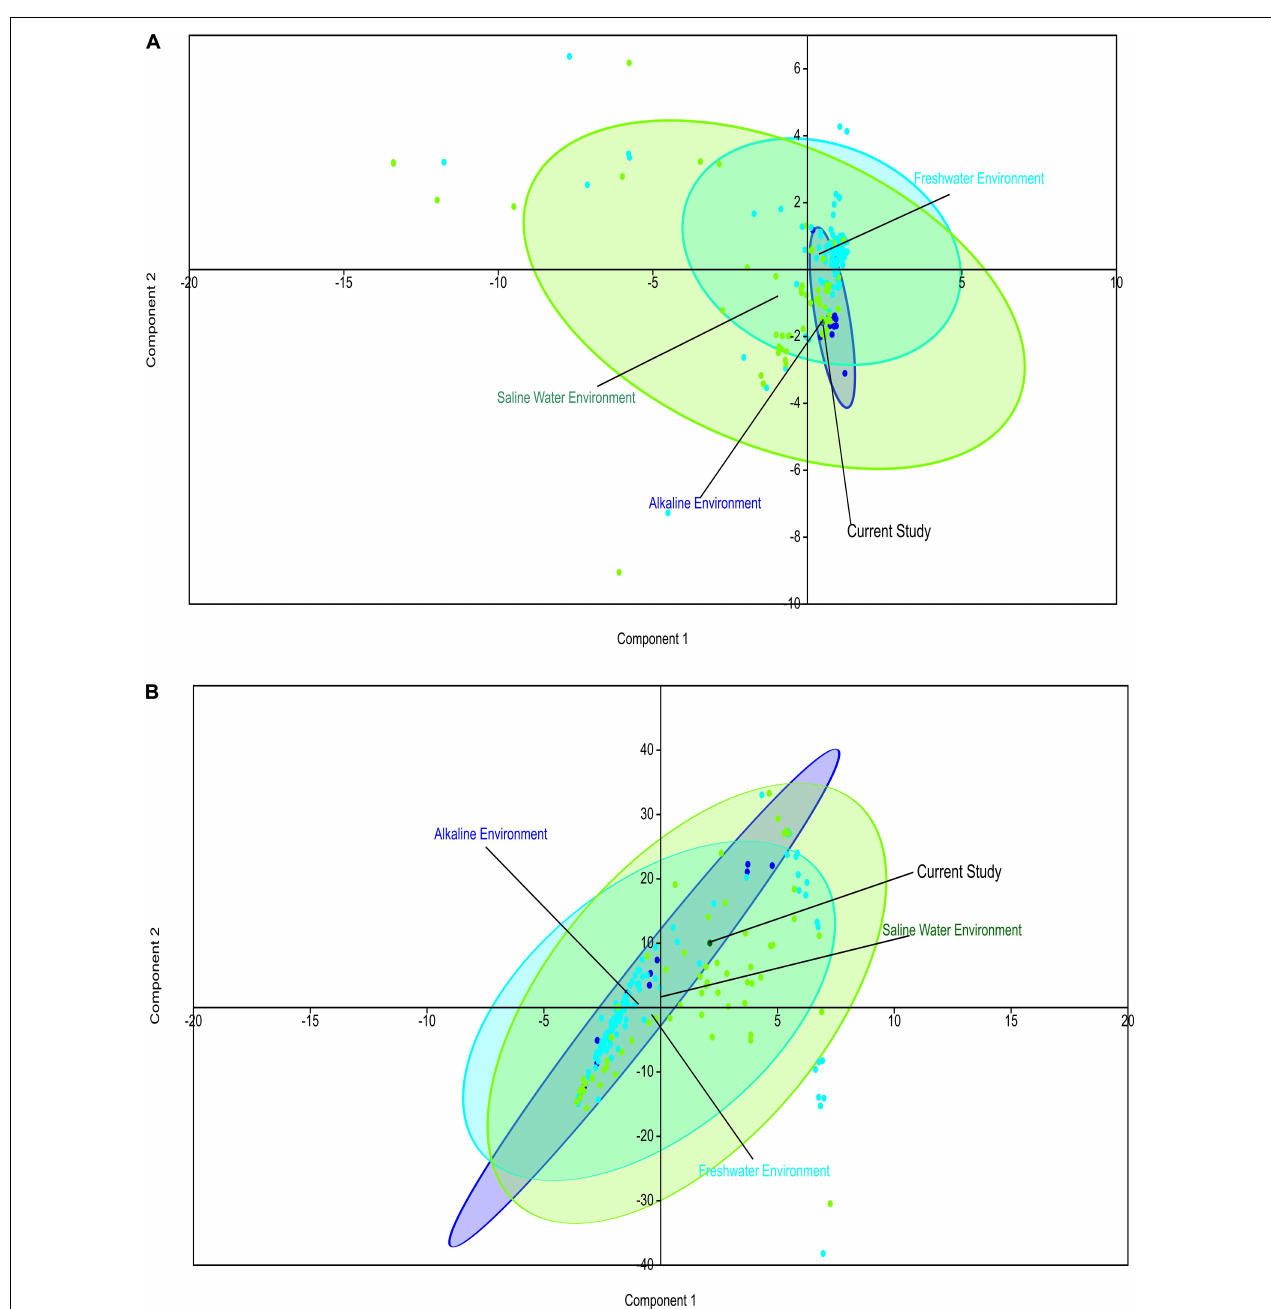
FIGURE 3 | Principal component analysis (PCA) of the diverse metagenomes with subsystem annotated protein features. Principal component analysis showing the clustering of the freshwater, alkaline water, and saline water metagenomes with subsystem database annotated metabolic at the hierarchy level L1 (A) and hierarchy level L2 (B)